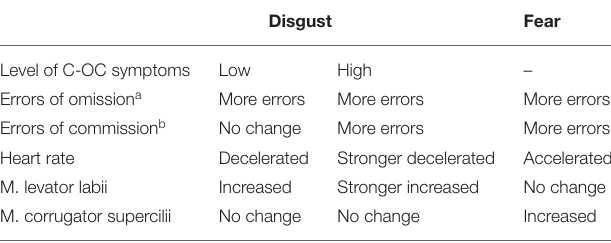
TABLE 1 | Expected change compared to the neutral